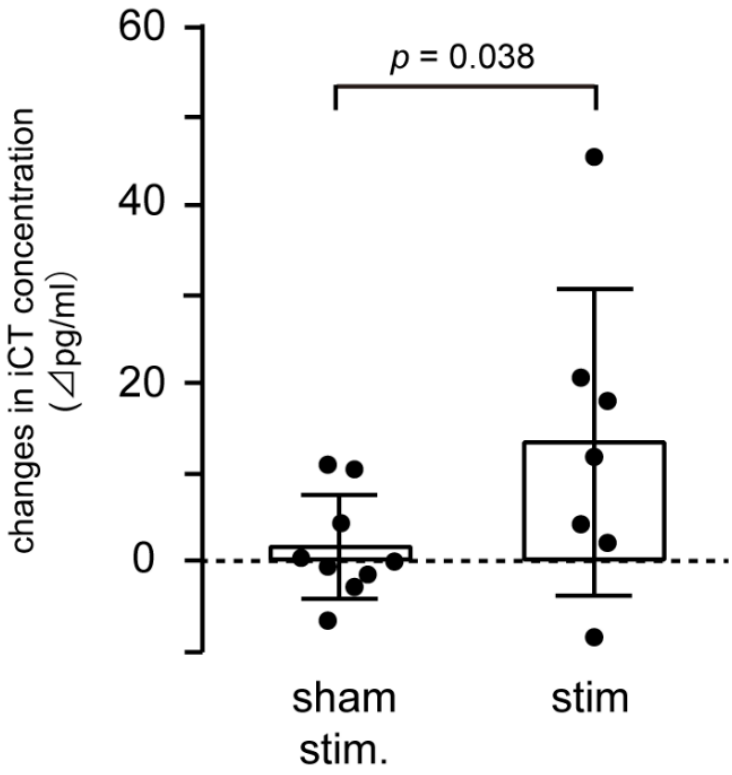
Figure 3. SLN stimulation increased systemic iCT concentration. Changes in systemic iCT concentration during stimulation (0.5 ms, 90 μA, continuous 40 Hz, 8 min) were compared between sham ( n = 9 in three rats) and SLN ( n = 7 in seven rats) stimulation. The Y-axis shows changes in iCT concentration from prestimulation values. A column represents mean value and closed circles indicate individual data. A p value indicates a significant difference ( p < 0.05) tested by unpaired t- test (one-tailed).